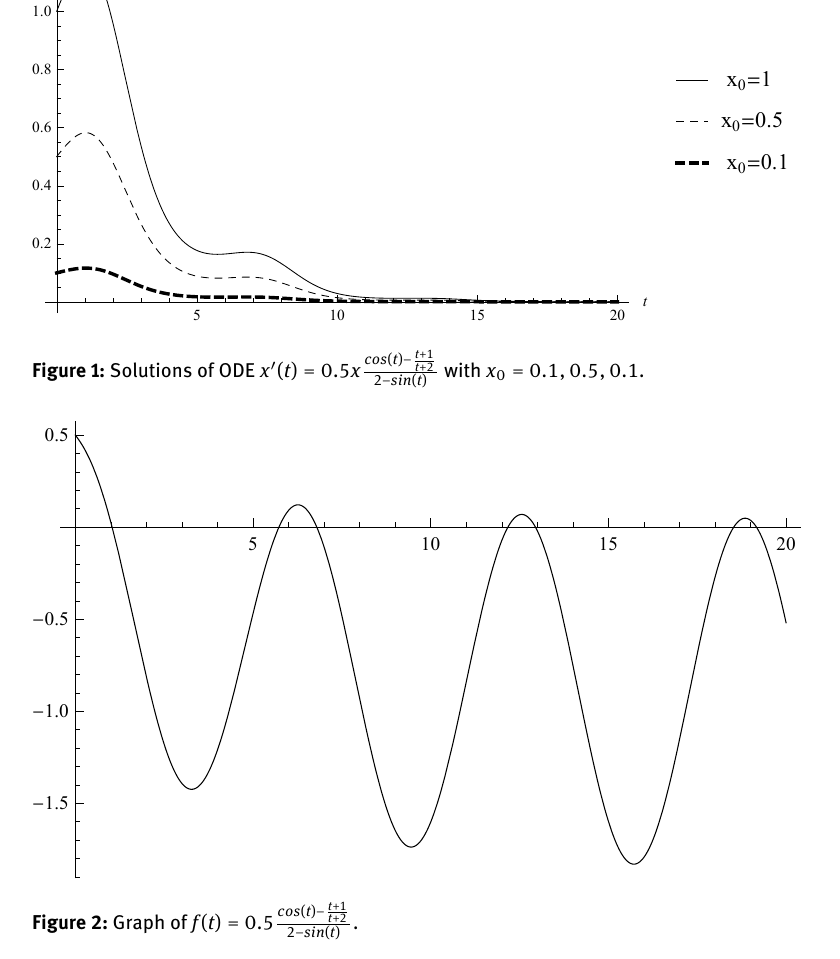
Figure 2: Graph of f ( t ) = 0.5 cos ( t )−